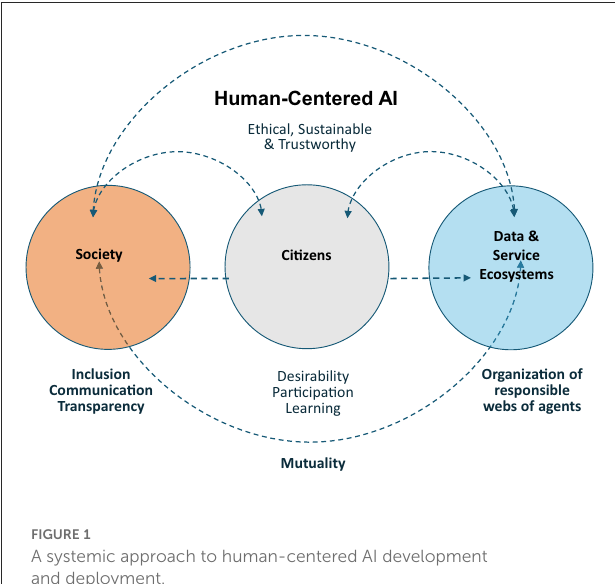
FIGURE1 A systemic approach to human-centered AI development and